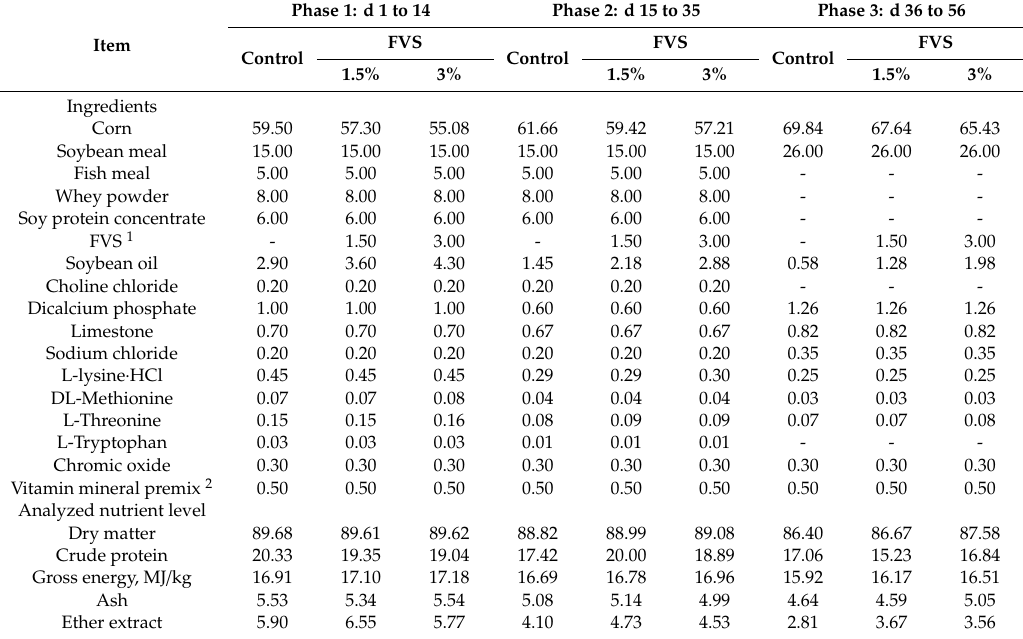
Table3. IngredientsandanalyzednutrientlevelsoftheexperimentaldietsusedinExp.2(%,